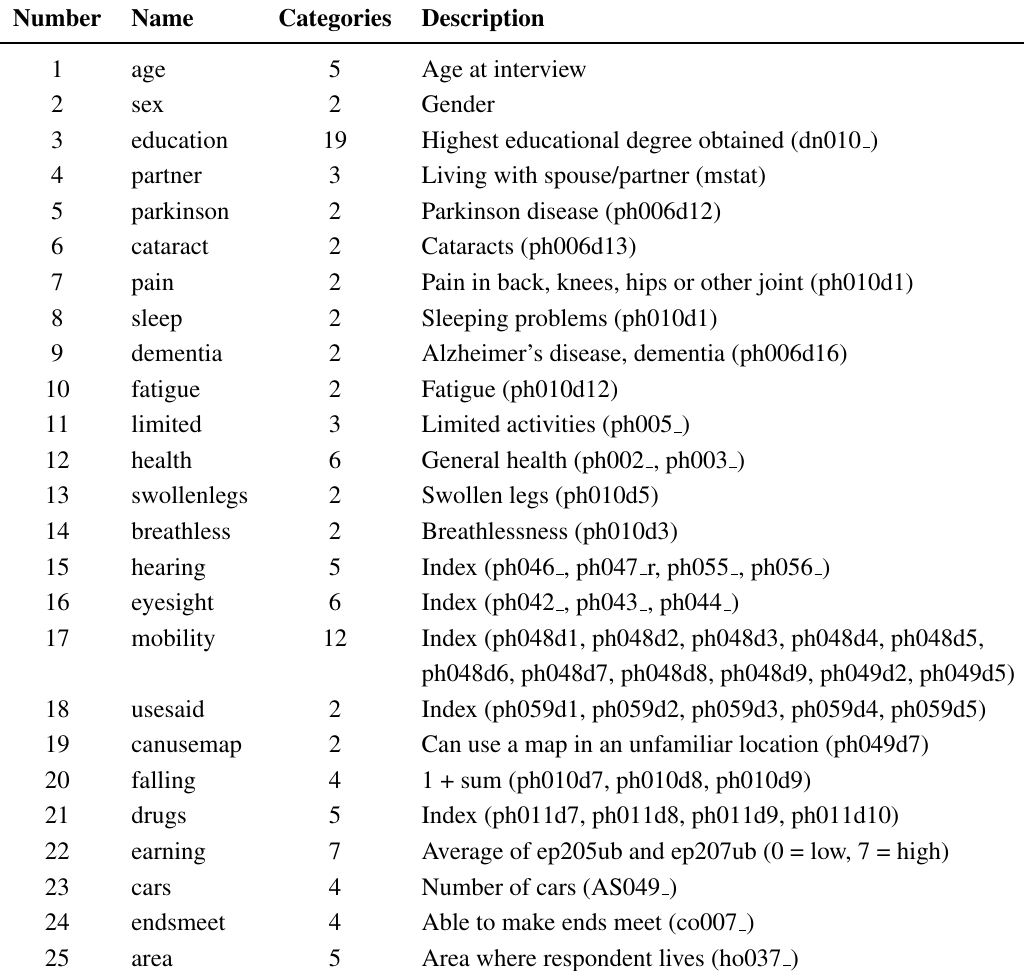
Table 1. Measures selected from the Survey of Health, Ageing and Retirement in Europe (SHARE) database. Seven variables are constructed as an index of SHARE